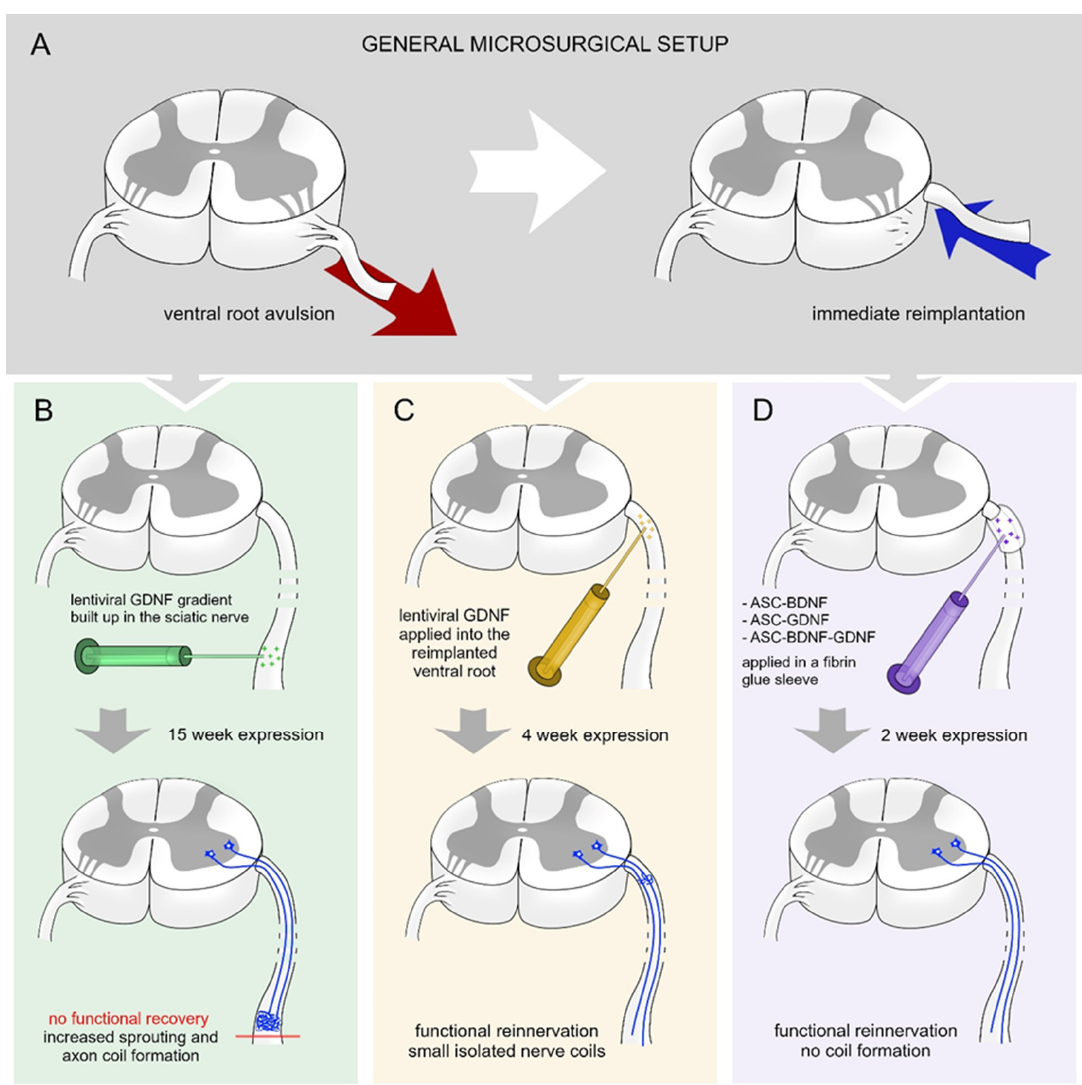
Figure 1. Various treatment strategies with BDNF and GDNF following ventral root injury. ( A ) Schematic overview of experimental ventral root avulsion and reimplantation. ( B ) Building up a proximo-distal gradient of GDNF [41] (15-week-long effect) in the sciatic nerve leads to robust axon coil formation that hinders the regeneration of the injured motoneurons and functional reinnervation of denervated hind limb muscles. ( C ) Shorter (4-week-long) expression period of time of GDNF [16] in the reimplanted ventral root results in the appearance of small isolated axon coils and functional recovery. ( D ) Transfected rat adipose tissue-derived stem cells (rASCs) grafted around the reimplanted ventral root producing GDNF and/or BDNF for 2 weeks [15] enhances elongative axon growth without coil formation and results in functional recovery.